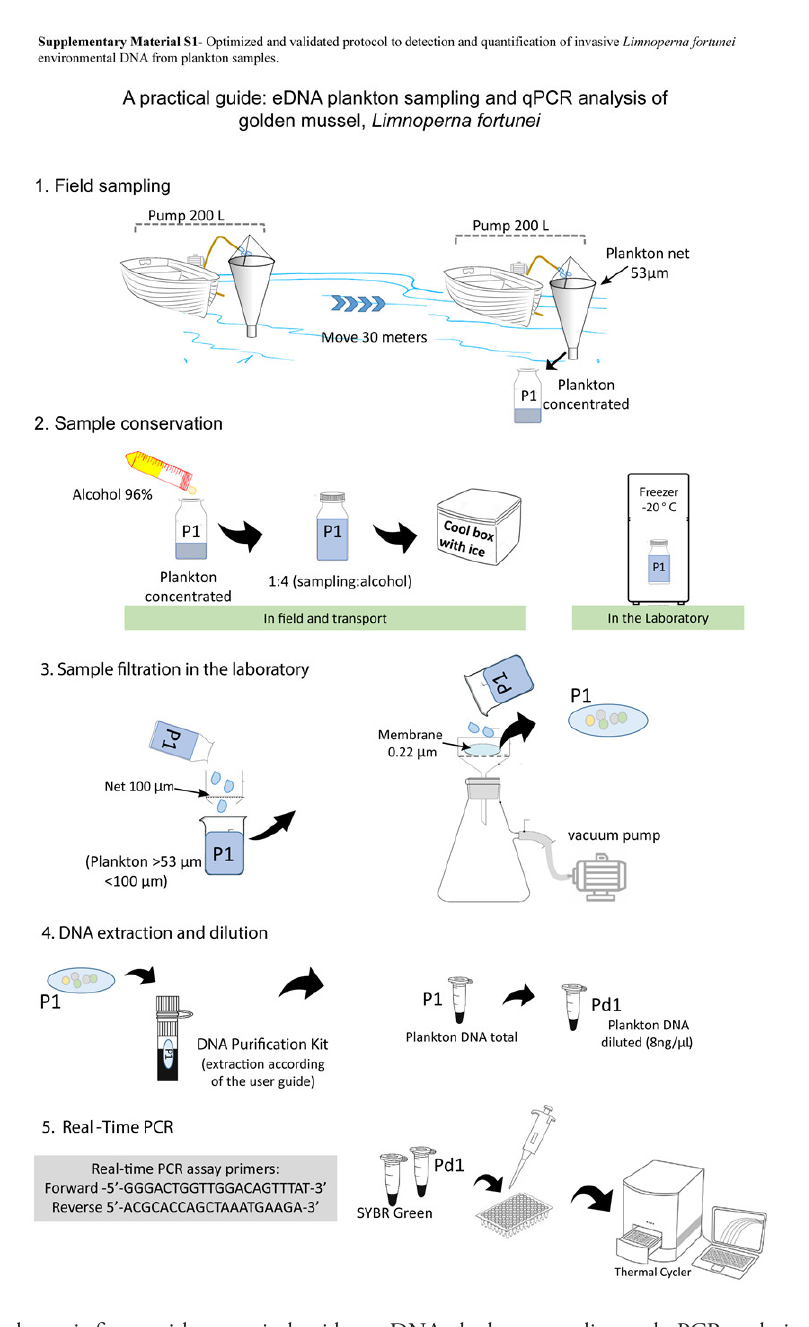
Figure 3. A schematic figure with a practical guide to eDNA plankton sampling and qPCR analysis of Limnoperna fortunei : “A practical guide: eDNA plankton sampling and qPCR analysis of golden mussel, Limnoperna fortunei ”. (1) Field sampling: Environmental DNA sampling using a plankton net (mesh opening of 53 µm), with a motor pump and a hose. Collect twice at the same sample site (filtering 200 L each) at two points (30 meters between each one) totalizing 400 L of water. Concentrate the sample in the same bottle; (2) Sample conservation in the field: Fix the collected sample with 96% ethanol in the proportion of 1:4 (sampling:ethanol). Keep the flasks with the samples in ice until getting to the laboratory. Store the sample in a freezer at -20 °C; (3) Sample filtration at the laboratory: Pre-filter the samples with a 100 µm net. Use the filtrate to filter in 0.22 µm smooth membrane filtrates, with the aid of a vacuum pump. Sterilize the materials between one filter and another (UV light); (4) DNA dilution: Extract the DNA from the membrane using a purification kit, following the manufacturer’s recommendation. Quantify the total DNA extracted and standardize at 8.0 ng of DNA.µL -1 ; (5) Real-time PCR: Perform the PCR reaction in a 20 µL in a final volume containing 10 µL of QuantiFast SYBR Green PCR Mix (Qiagen), 1.0 µL of Forward primer (20µM), 1.0 µL of Reverse primer (20 µM), 8.0 ng of eDNA/reaction, and 3.0 µL of RNAse free water (Qiagen) and the program as follows: 5 min at 95 °C, 35 cycles of 10 seconds at 95 °C, and 15 seconds at 60